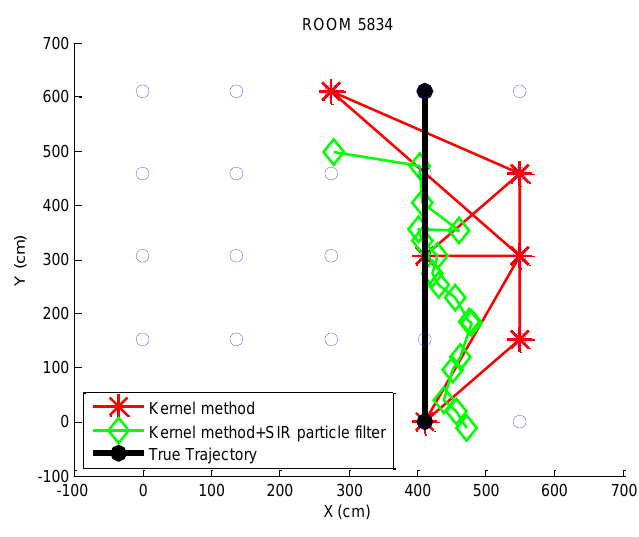
Figure 14. The dynamic positioning results by the kernel